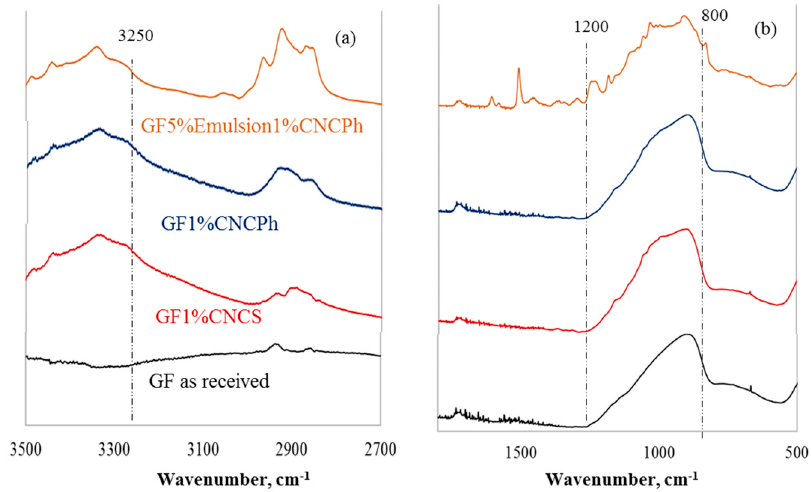
Figure 3. FTIR spectra ( a ) 3500 cm − 1 to 2700 cm − 1 , ( b ) 1800 cm − 1 to 500 cm − 1 of coated GF.